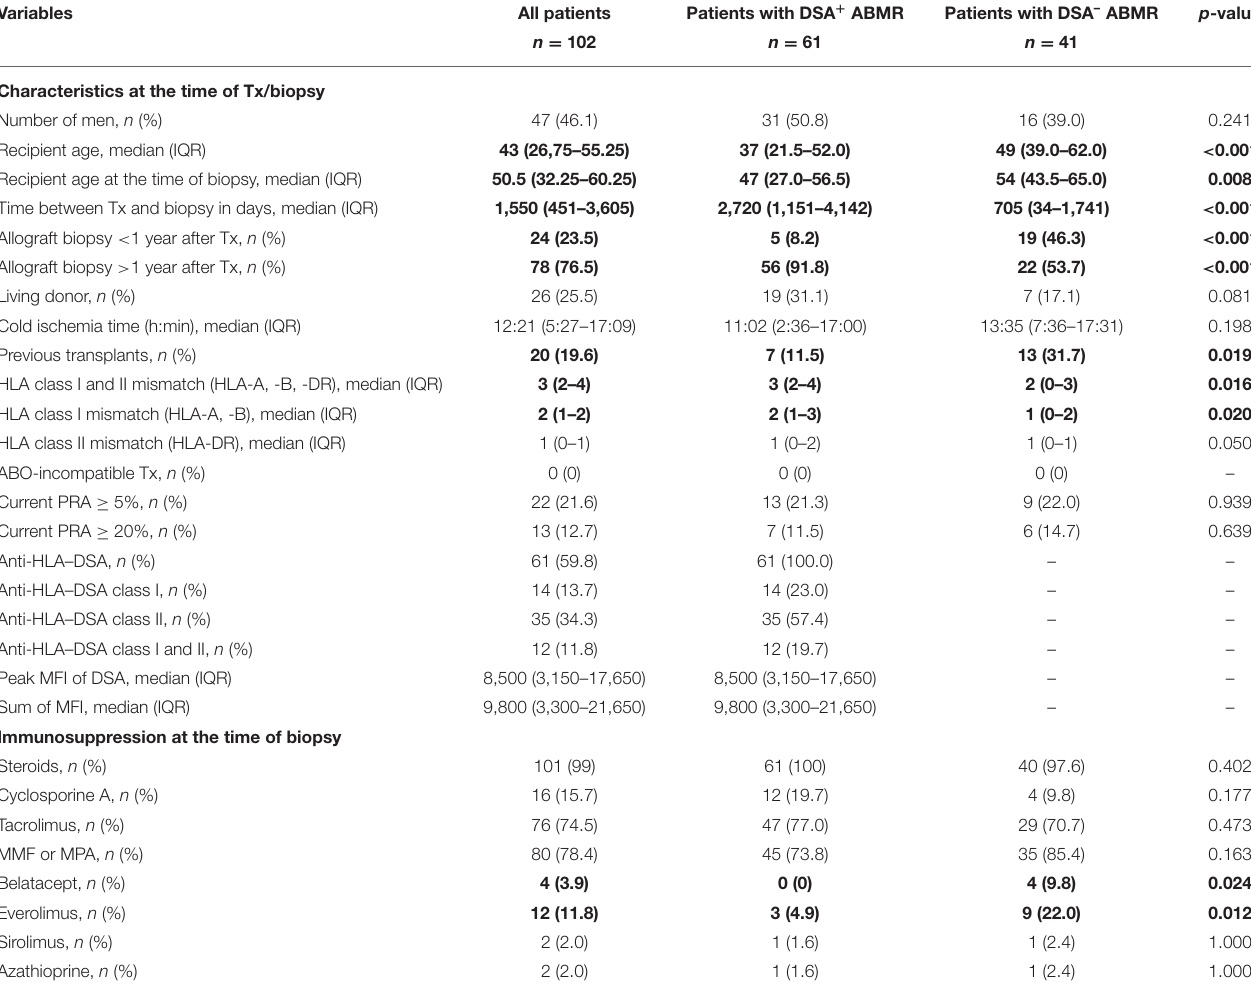
TABLE 2 | Baseline characteristics of 102 renal allograft recipients with biopsy-proven antibody-mediated rejection. Variables All patients Patients with DSA + ABMR Patients with DSA – ABMR p